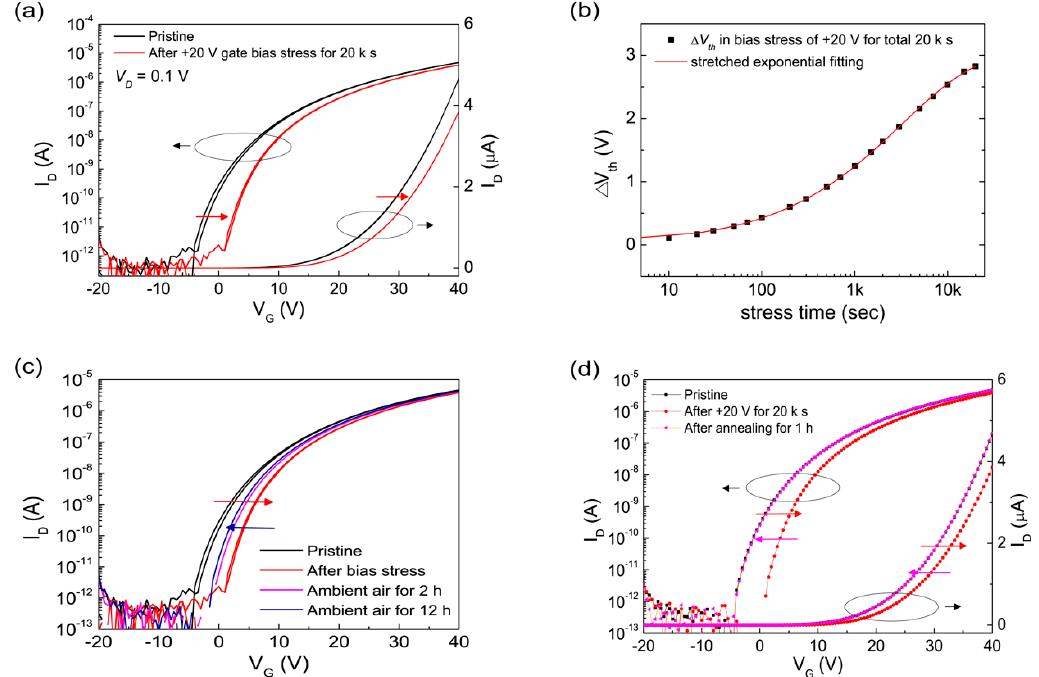
Figure 4. ( a ) The instability behaviours of transfer characteristics (log( I D ) – V G and I D – V G ) of the ZnO FETs (at V D = 0.1 V) under prolonged positive ( + 20 V) gate bias for 20,000 s at room temperature (R.T.). The transfer curve shifts parallel to positive direction. ( b ) V th shifts as a function of stress time in positive ( + 20 V) bias stress (PBS) at R.T. ( c ) The recovery behaviour of ZnO FETs at R.T in ambient air after PBS. ( d ) The shifts of the transfer characteristics under thermal annealing (at 120 ◦ C) in ambient air.